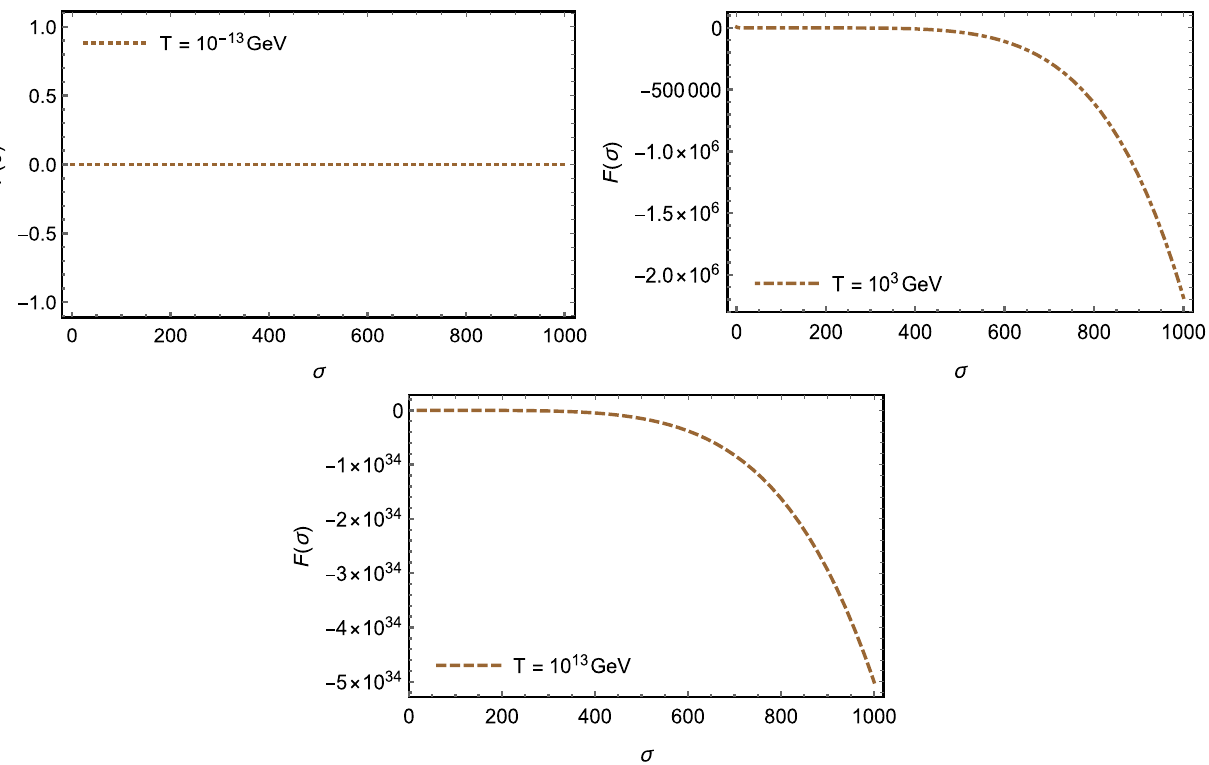
Fig. 5 ThefigureshowsthemodificationoftheHelmholtzfreeenergy F (σ) duetotheparameter σ (itsunitisGeV − 1 )consideringthetemperatures of cosmic microwave background (top left), electroweak scenario (top right) and the early inflationary universe (bottom)